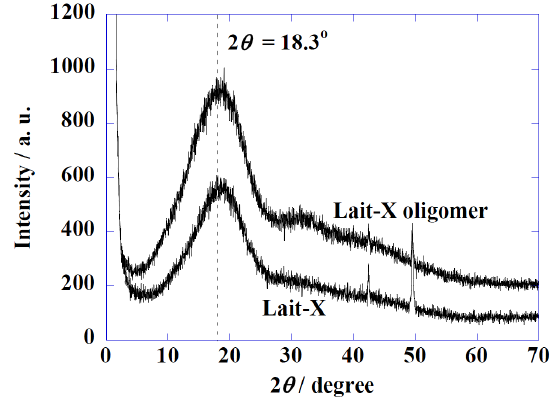
Figure 2. Wide-Angle X-ray Diffraction (WAXD) patterns of Lait-X oligomers and Lait-X